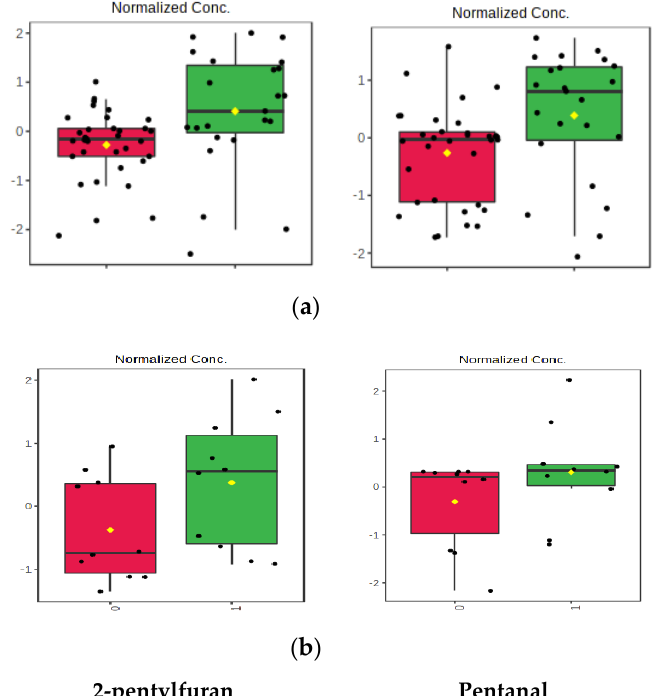
Figure 2. Box and whisker plots showing the change in 2-pentylfuran and pentanal in Group 1 ( a ) and Group 2 ( b ).